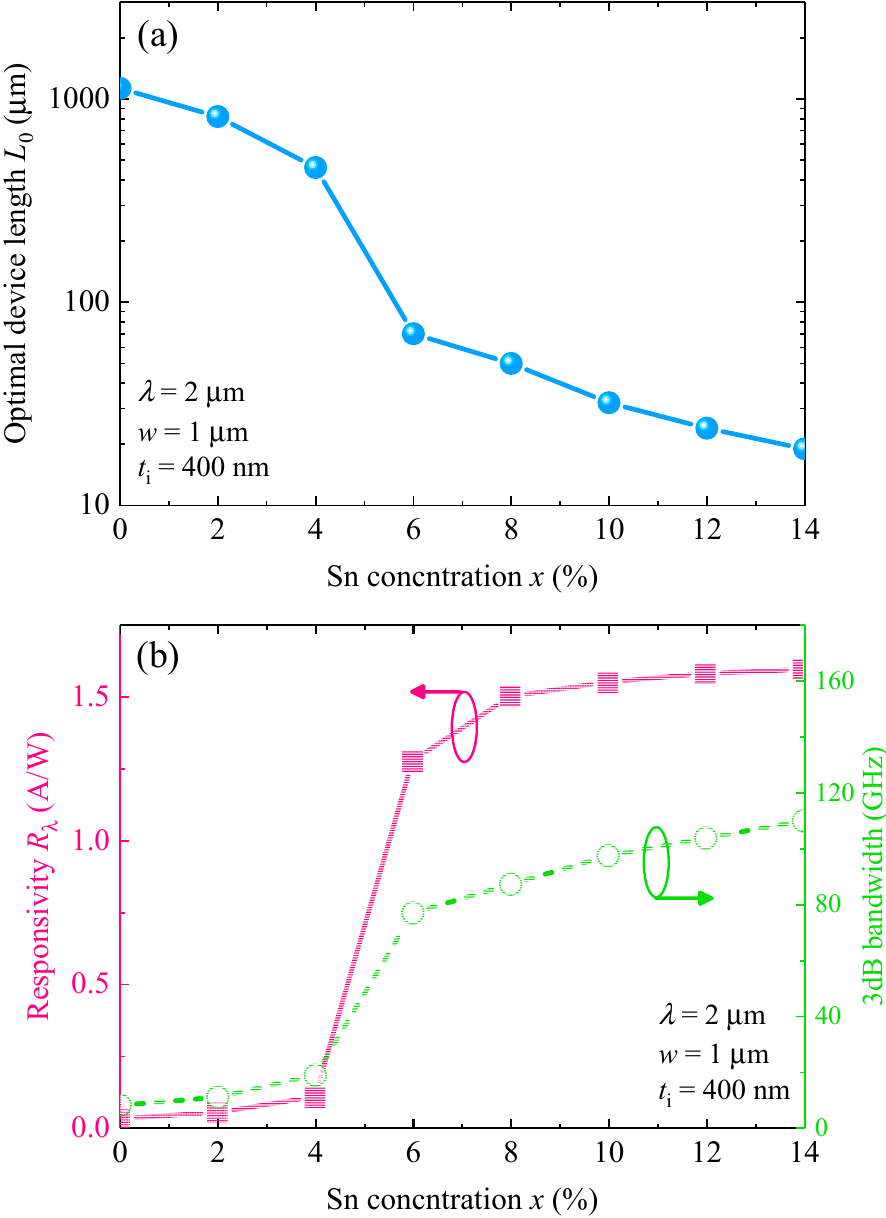
Figure 9. ( a ) Variation of optimum length of the GeSn waveguide photodetectors with various Sn concentrations at λ = 2 µm. ( b ) Variation of 3-dB bandwidth and responsivity against Sn concentration for optimized GeSn waveguide photodetectors.